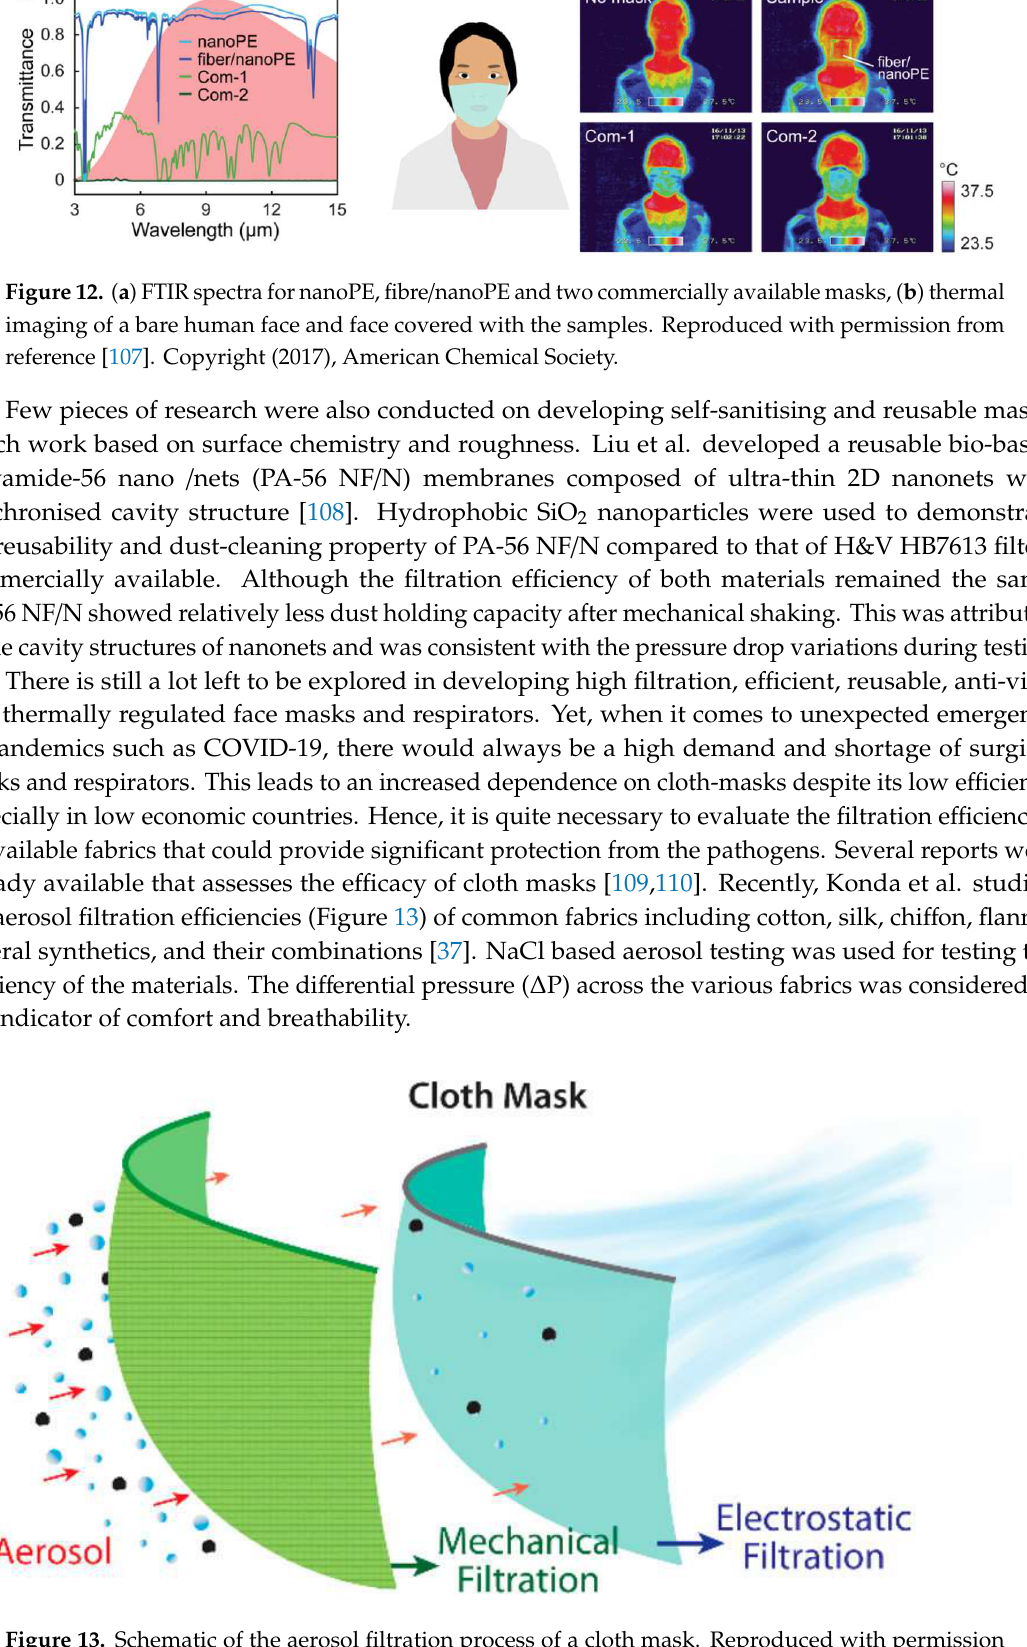
Figure 13. Schematic of the aerosol filtration process of a cloth mask. Reproduced with permission from reference [37] . Copyright (2020), American Chemical Society.